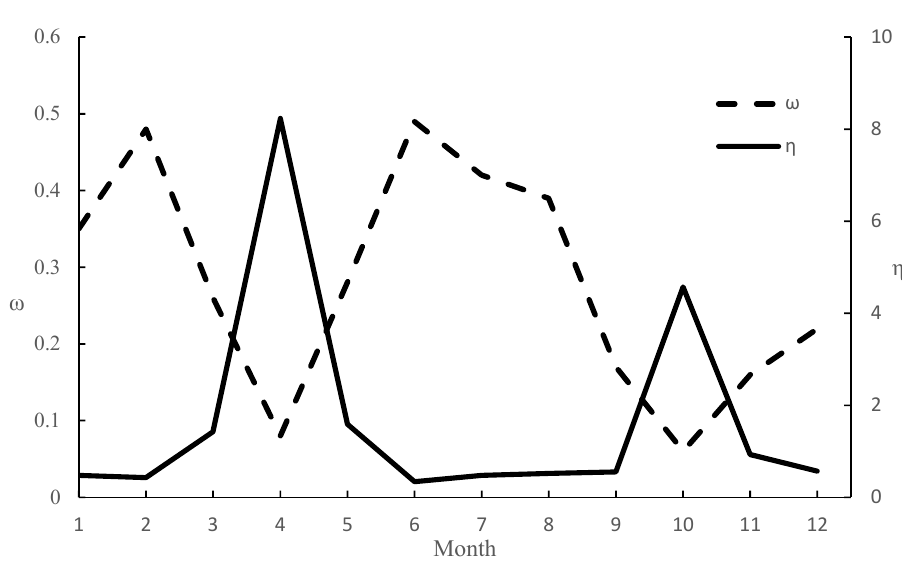
Figure 6. Optimization result of the weighting factor( ω ) and IWTR( η ).